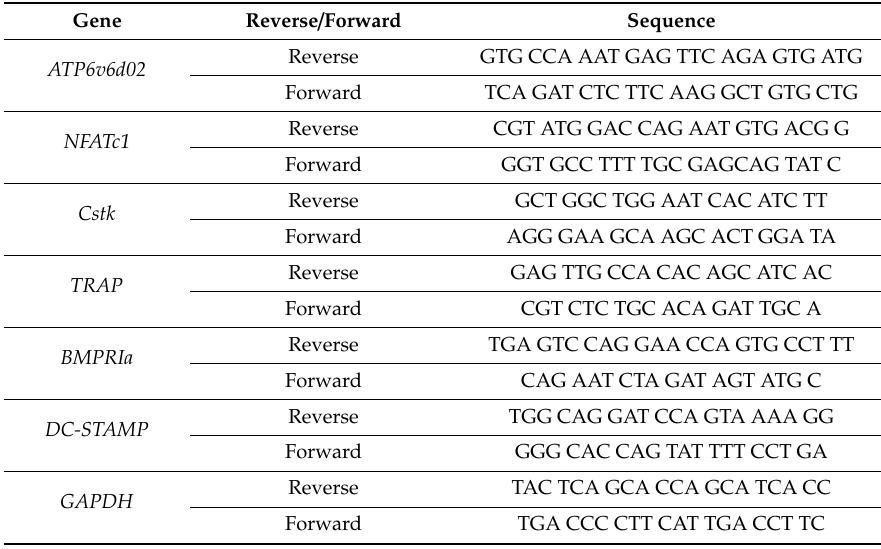
Table 1. Primers for osteoclast marker genes and GAPDH.